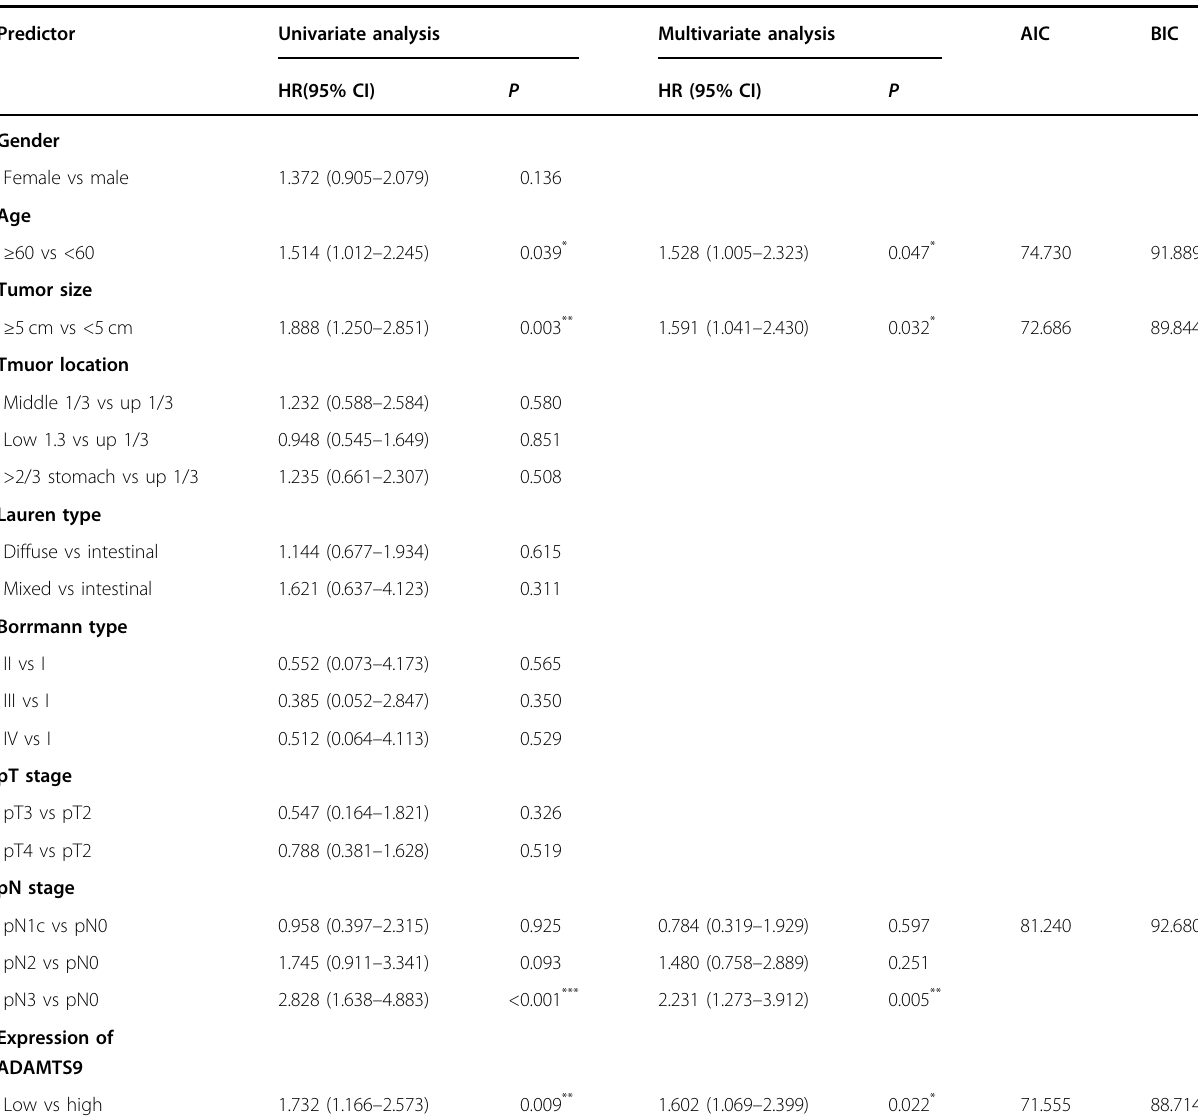
Table 1 Univariate and multivariate Cox proportional hazard models for overall survival of gastric cancer